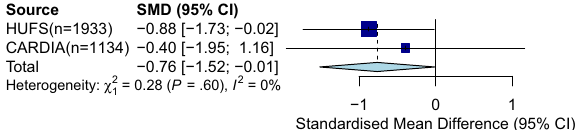
Fig. 4 Forest plot of meta-analysis for MR analysis from two studies (HUFS and CARDIA), with a total of 3067 African